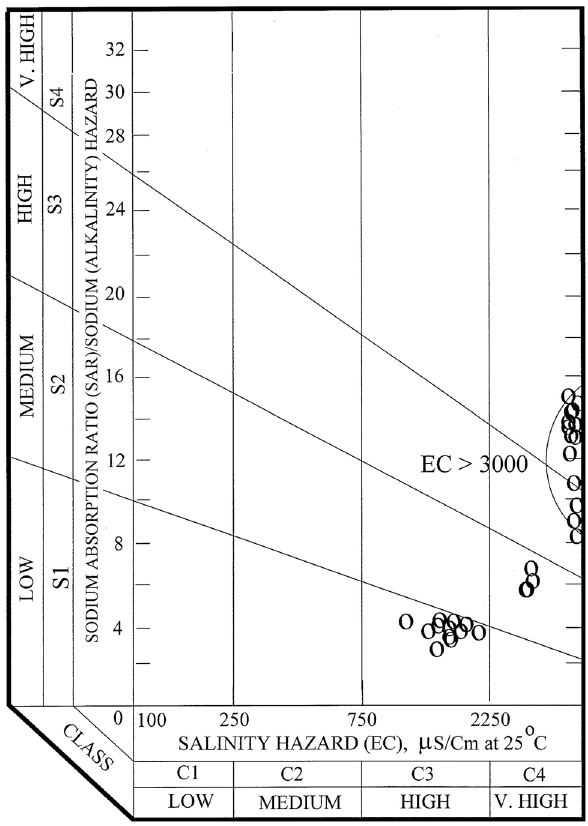
Fig. 7 Groundwater quality for irrigation (after Richards 1954)